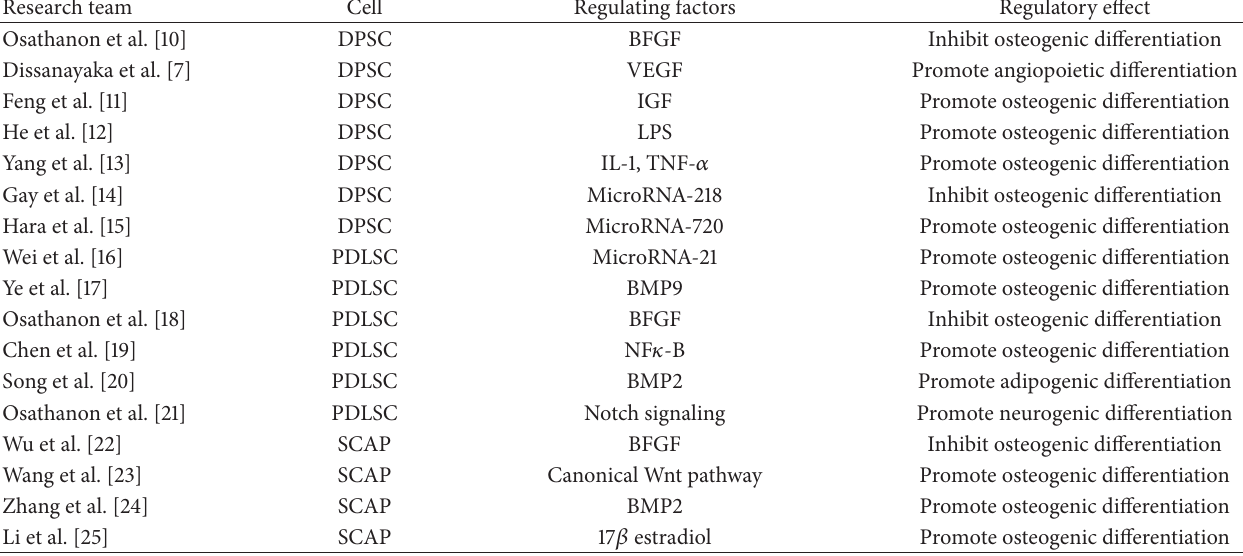
Table 1: The effects of different regulating factors on